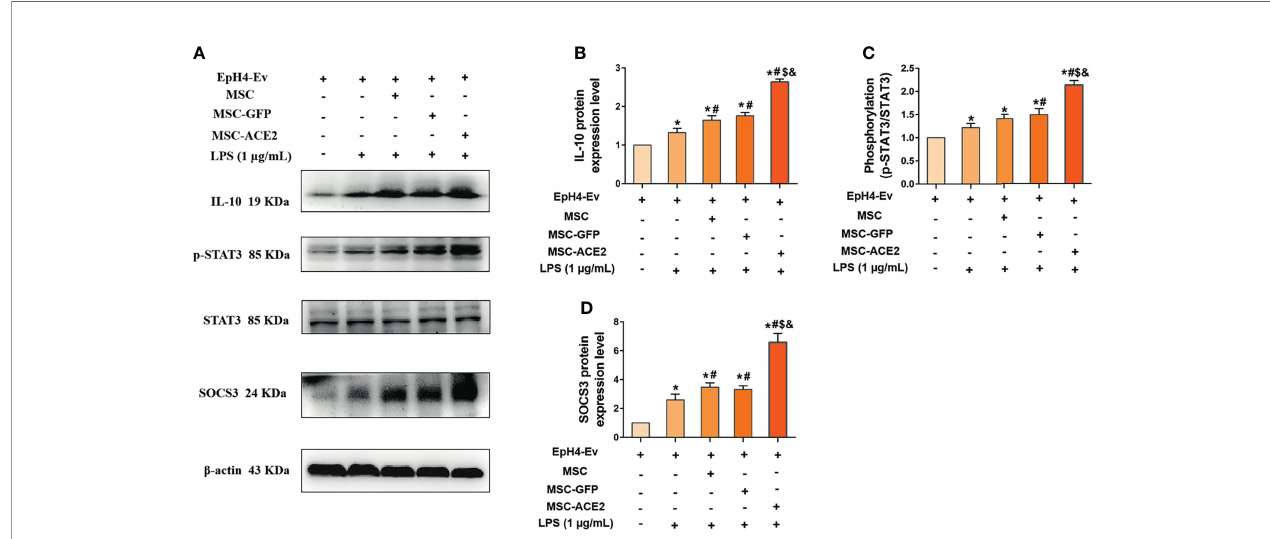
FIGURE 7 | MSC-ACE2 upregulates IL-10/STAT3/SOCS3 signaling pathway expression to suppress LPS-induced in fl ammation in EpH4-Ev cells. (A) Detection of relative protein expression levels of IL-10, phosphorylation levels of STAT3, STAT3 and SOCS3 by Western blot; (B – D) , Statistics of the IL-10, phosphorylation levels of STAT3, STAT3 and SOCS3 Western blot results. Experiments were repeated three times and data were presented as the mean ± SEM (n = 4). * P < 0.05 vs. EpH4-Ev; # P < 0.05 vs. LPS; $ P < 0.05 vs. MSC; & P < 0.05 vs. MSC-GFP.